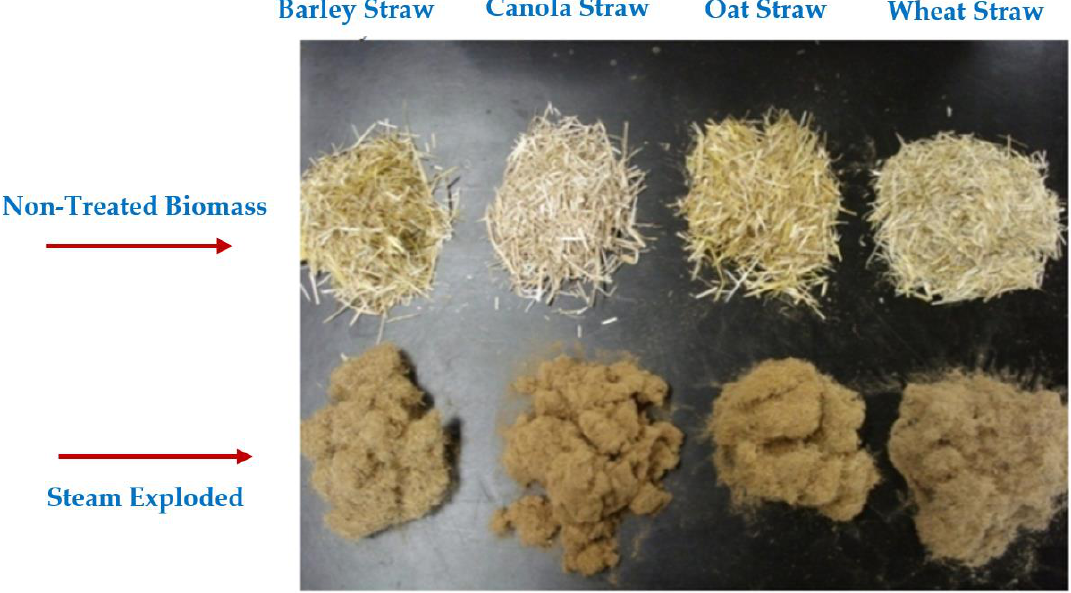
Figure 5. Images of non-treated and steam exploded biomass (adapted from [56]).